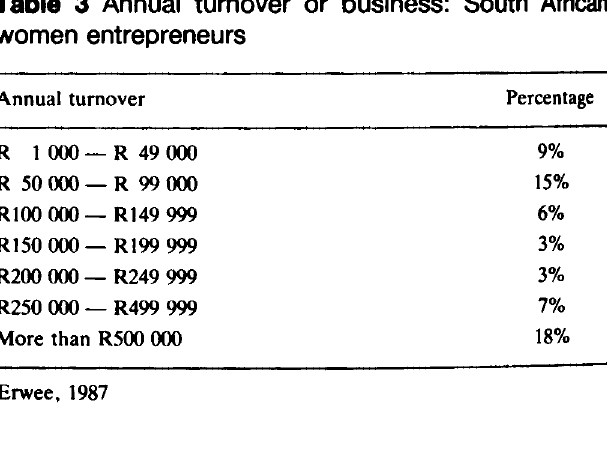
Table 3 Annual turnover or business: South